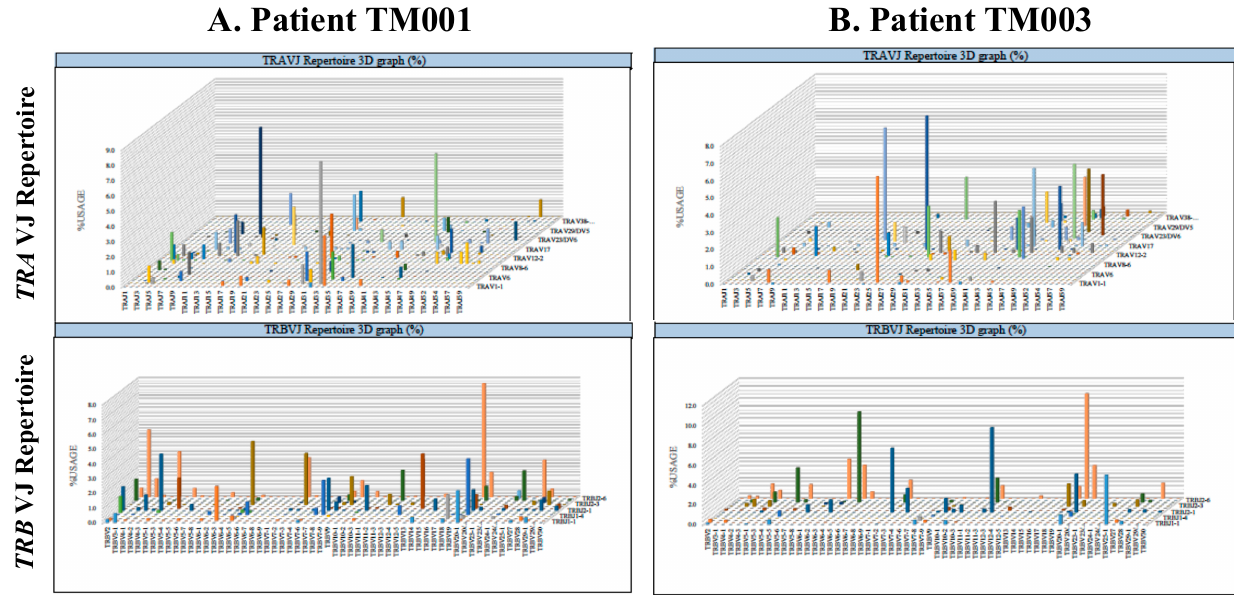
Figure 3. The typical results of the TRA and TRB repertoires in esophageal squamous cell carcinomas (ESCCs) 2.3. Ratio of PD-L1 mRNA to CD8B mRNA within Tumor Tissues Significantly Higher in Patients with Poor Prognoses after Salvage Surgery for Locally Relapsed Esophageal Squamous Cell Carcinoma after Definitive Chemoradiation Therapy